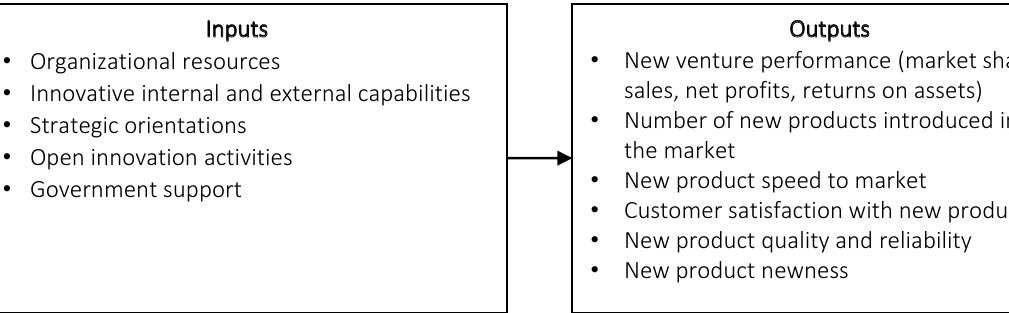
Figure 6. Commercialization efficiency indicators at the macro level